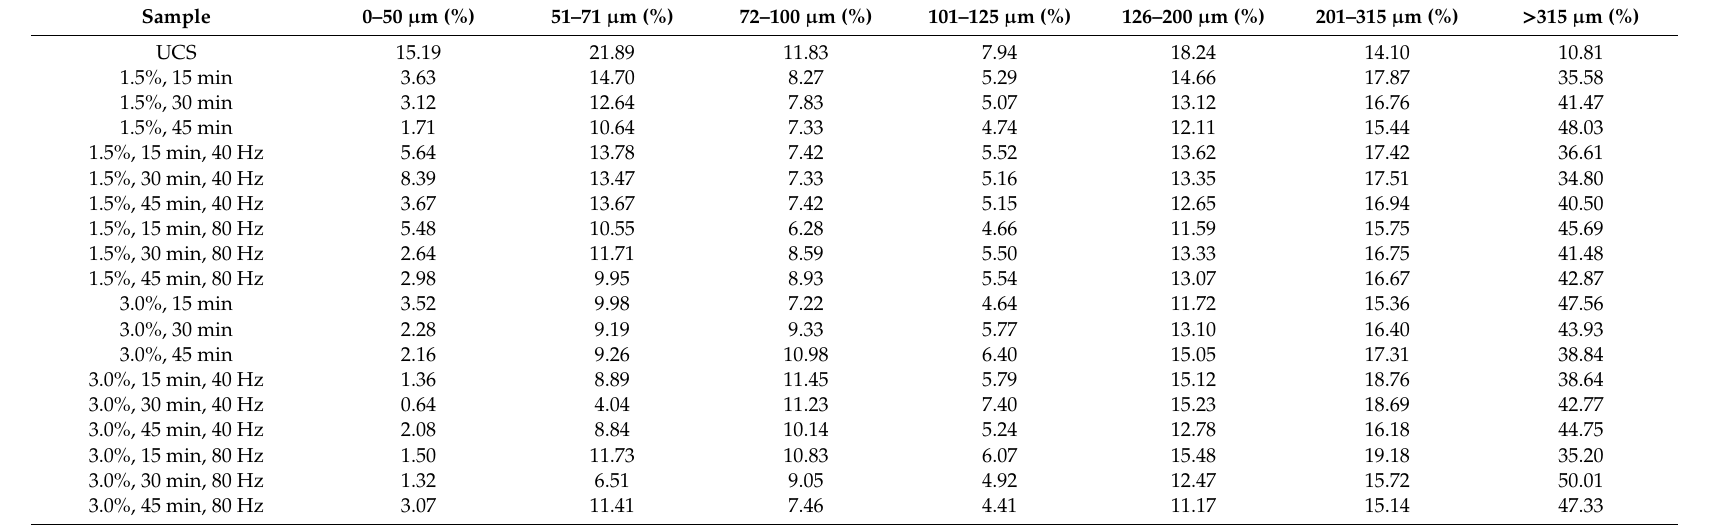
Table 3. Grindability of cocoa shell samples before and after the HVED